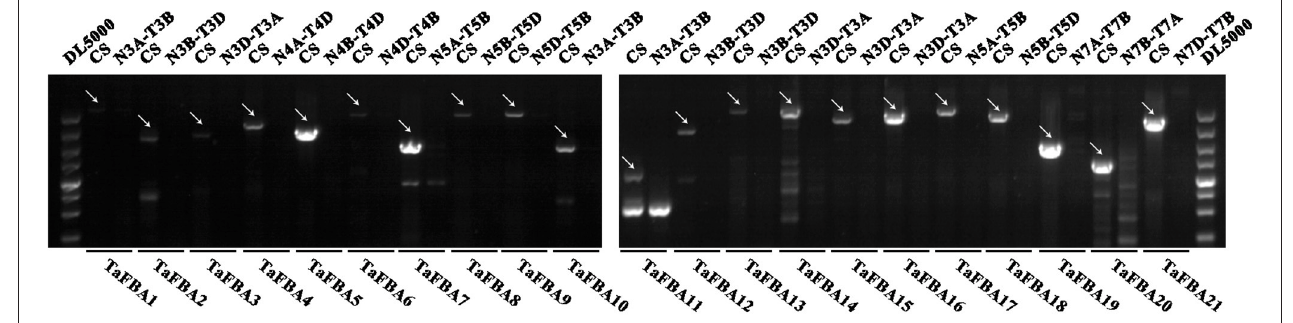
FIGURE 1 | Genomic PCR amplification results of the TaFBA genes using Chinese spring nulli-tetrasomic lines. PCR amplification was performed using Chinese Spring (CS) and nulli-tetrasomic lines of Chinese Spring (N4-T4) genomic DNA. DL5000 is DNA marker (100, 250, 500, 750, 1,000, 1,500, 2,000, 3,000, 5,000 bp). The white arrows indicated the target PCR